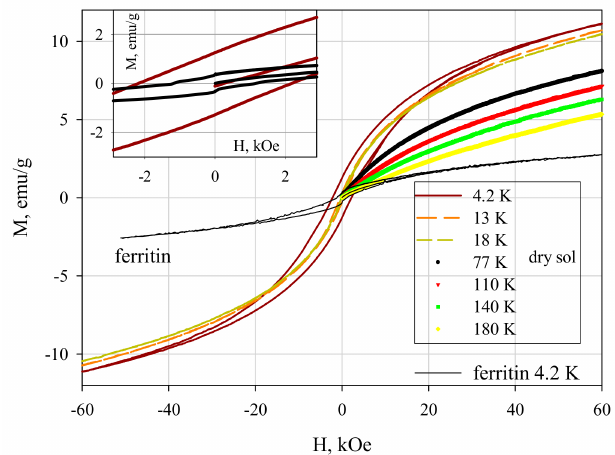
Figure 7. Dependence of magnetization M(H) of dried sol of ferrihydrite nanoparticles and of commercial ferritine at different temperatures. Inset: M(H) in the vicinity of H =